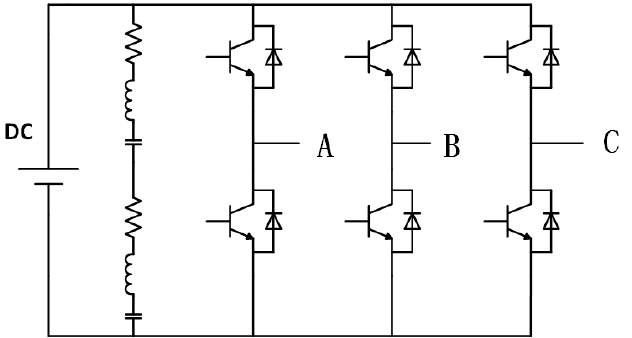
Figure 6. Three phase electric spring topology.